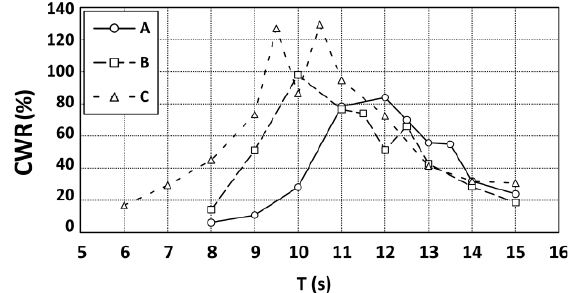
Fig. 7. Capture width ratio of the OWC as a function of wave period (full-scale values) for H=0.02